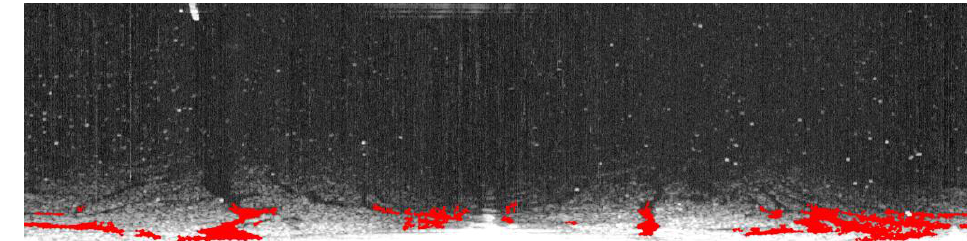
Figure 14. Oil spill segment identified using the OSD method proposed by Zhu et al.